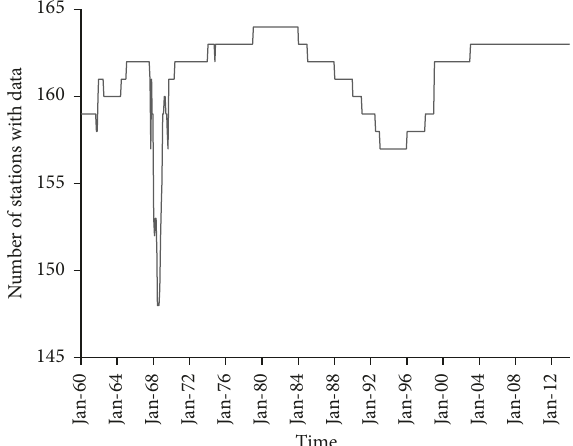
Figure 4: Number of stations with data